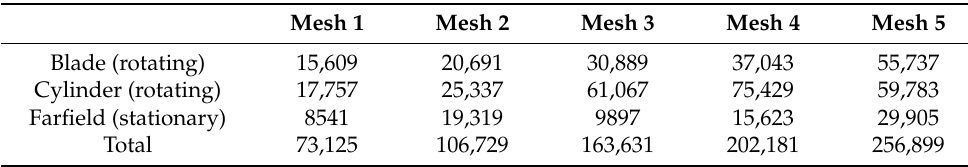
Table 2. Meshes used in the convergence analysis (SM).